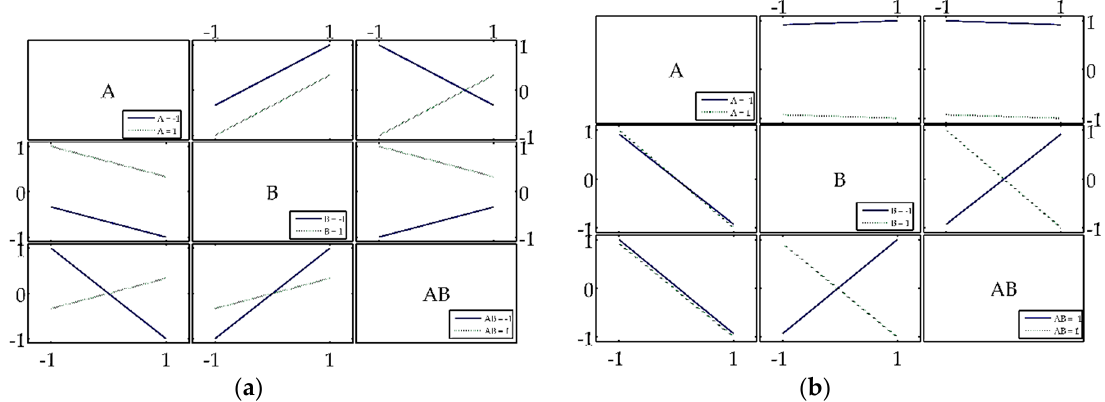
Figure 8. Comparison of the significant effects for: ( a ) Transmission Loss (TL) as a response; ( b ) area of Acoustic Shadow (AS) as a response.